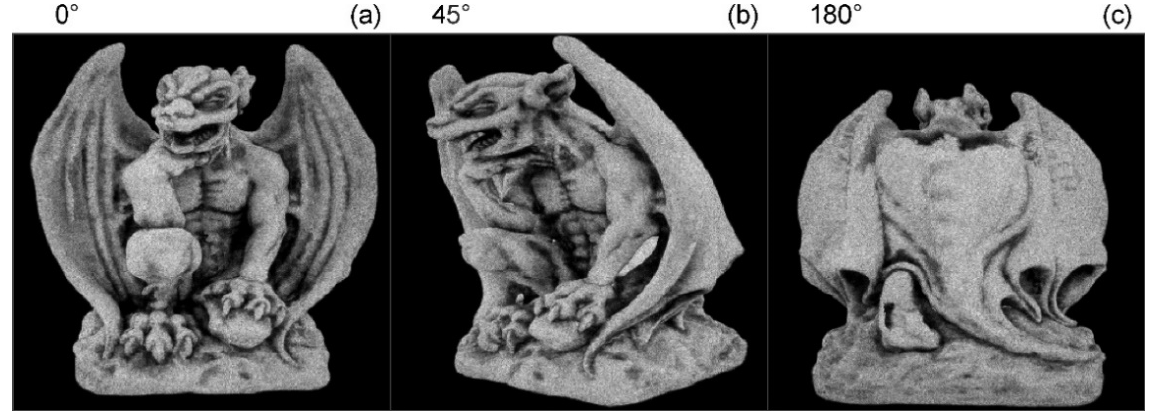
Figure 7. 2D MFFT AS reconstructions for different perspective angles: ( a ) 0°, ( b ) 45°, and ( c ) 180°. Optical reconstruction of CGH is carried out in the display setup presented in Figure 8.